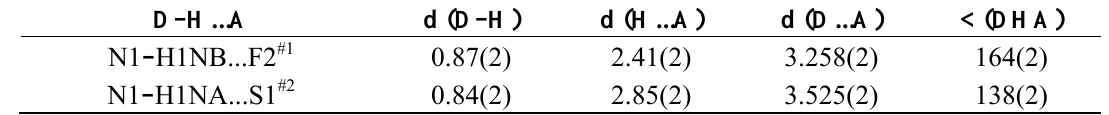
H F N S [Å and °]. 16 13 2 3